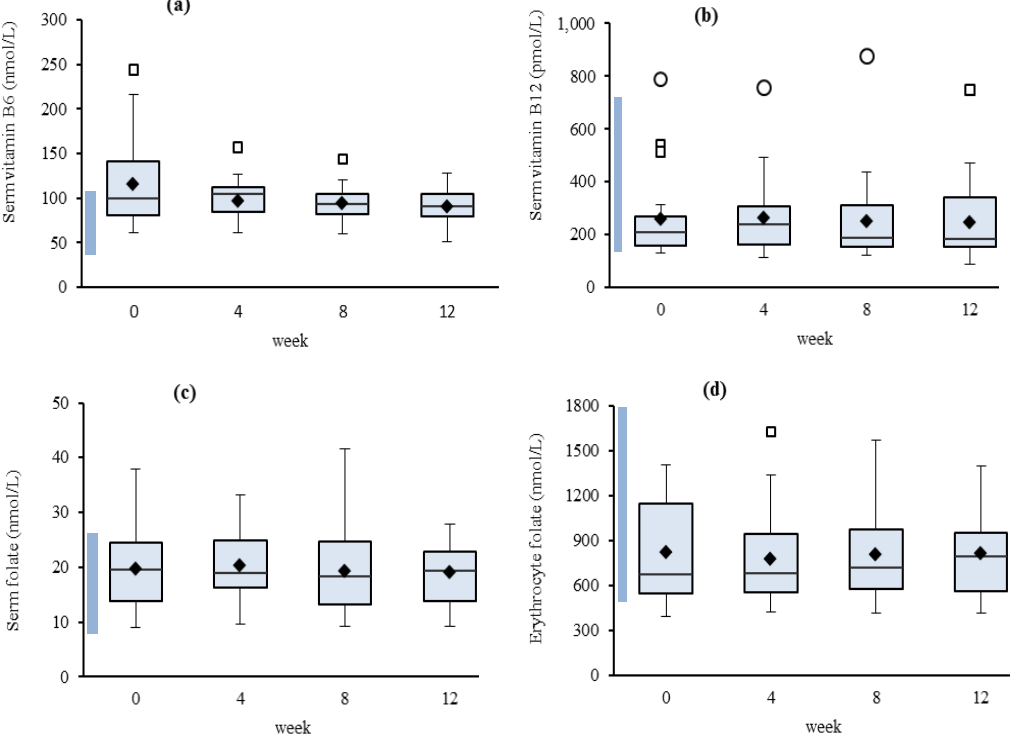
( a ), vitamin B ( b ), folate ( c ), and erythrocyte folate 6 12